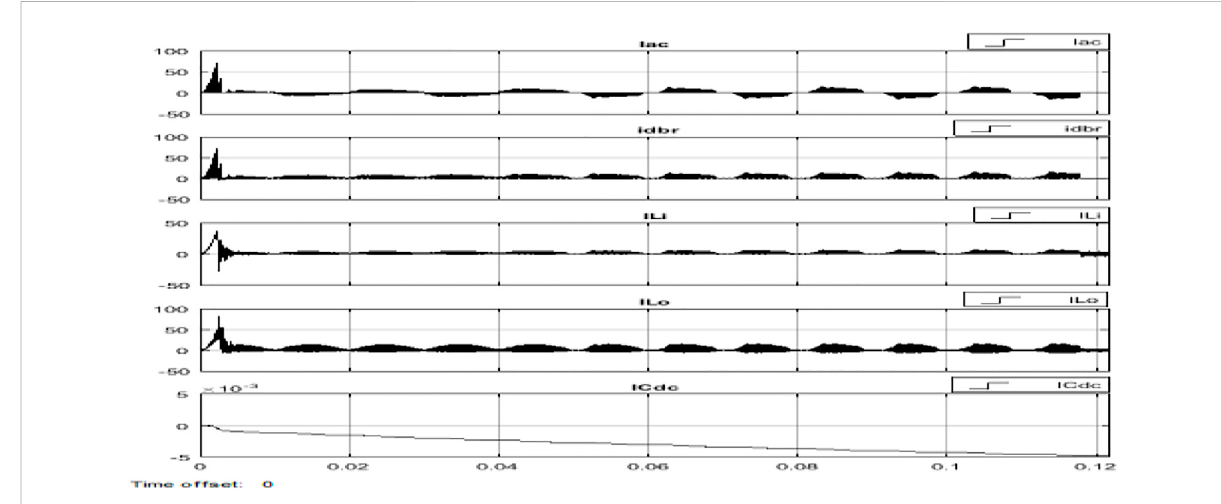
FIGURE 15 Current waveforms of BLDC motor drive.